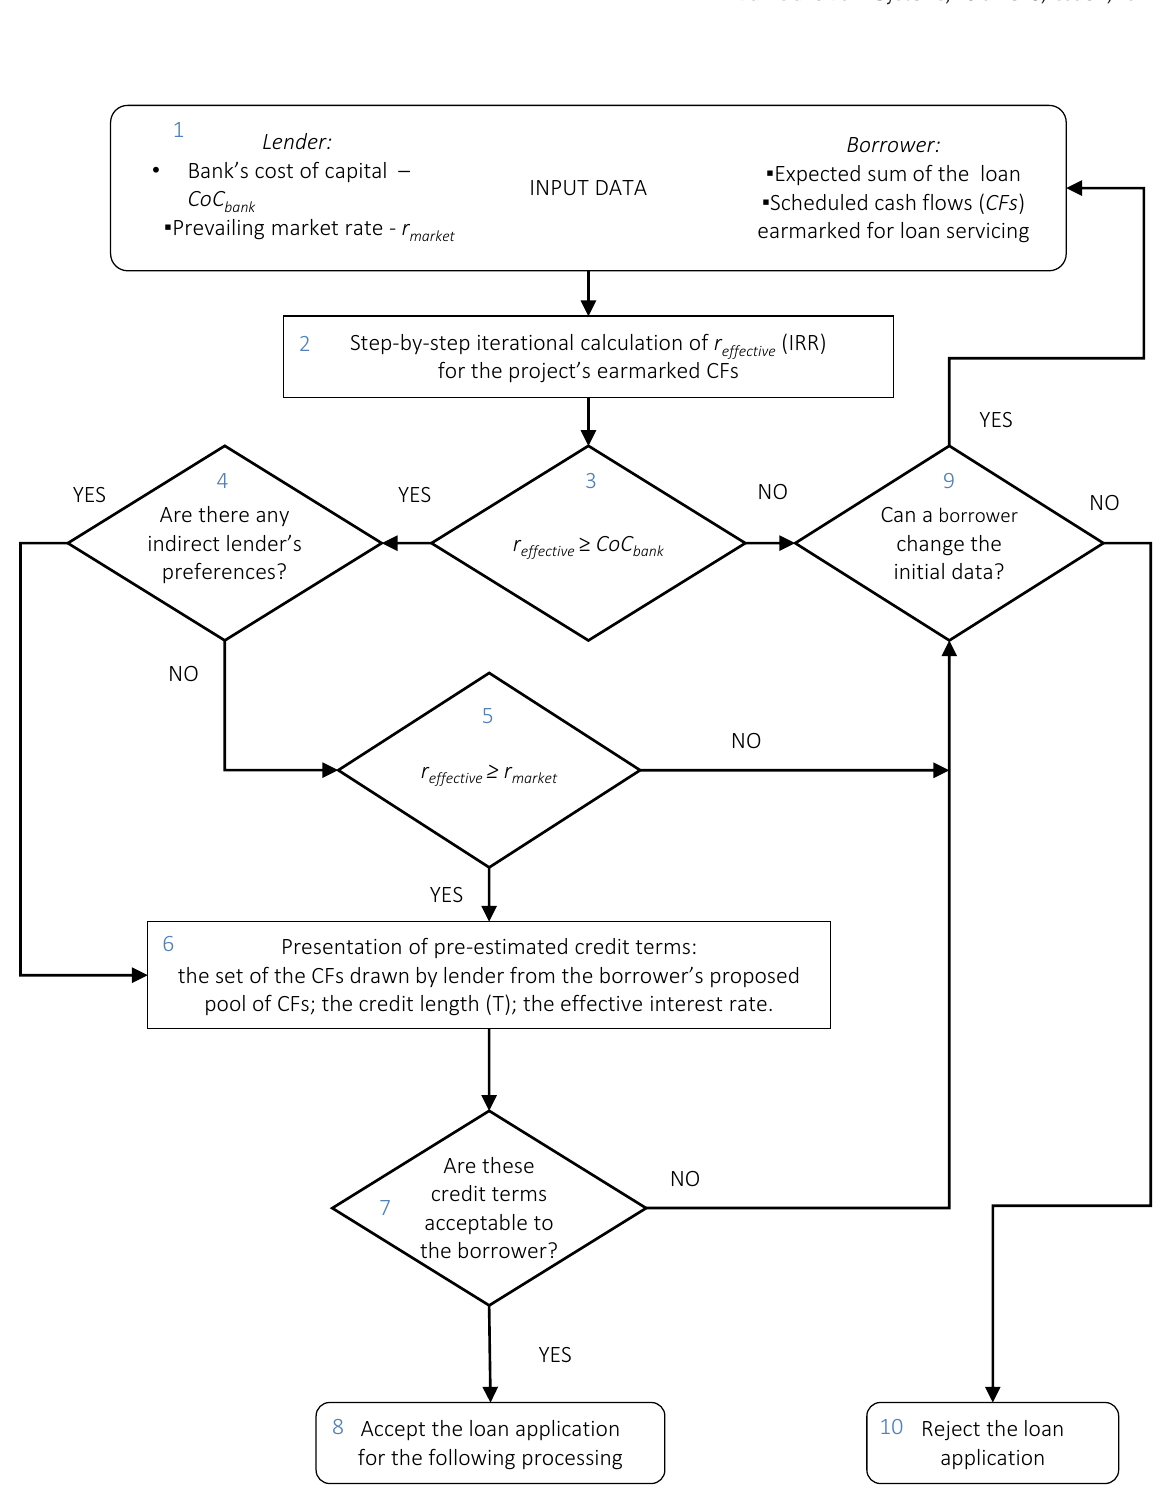
Figure 2. Preliminary evaluation of the loan